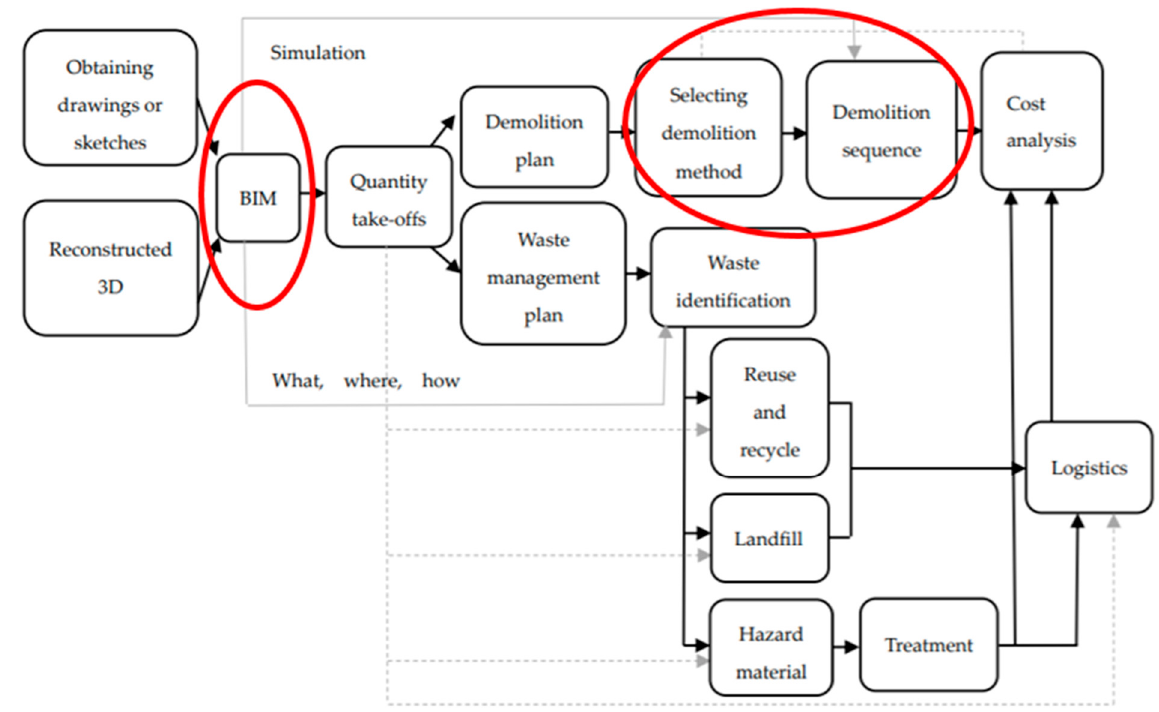
Figure 5. Model of BIM application in the demolition phase from Ge et al. [10].